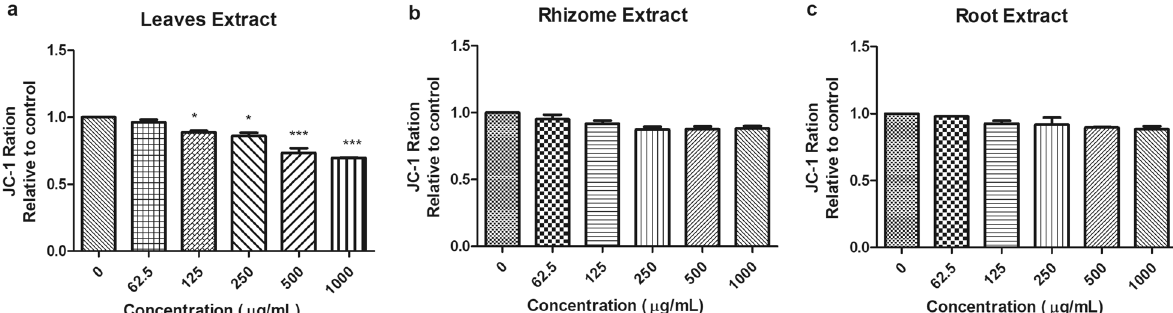
Fig. 5 Effect of Enhalus acoroides a L, b RH, and c R on mitochondrial membrane potential of MCF-7. Mitochondrial membrane potential (ΔψM) was measured by JC-1 fluorescence [fluorescence of JC-1 monomers (em 535 nm)/aggregates (em 590 nm)] in MCF-7 cells treated with (0, 62.5, 125, 250, 500, and 1000 µg/ml) for 48 h. Enhalus acoroides L showed significant decrease in ΔψM dose-dependently. Data are expressed as mean *** P < 0.001, * P <